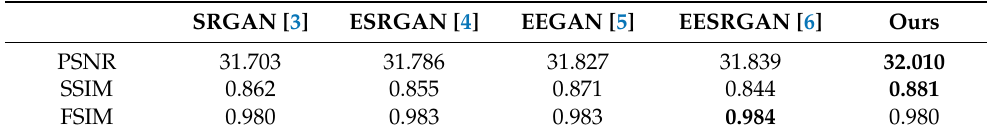
Table 7. SR result performance comparison in the WHU-RS19 dataset, where the best results are shown in